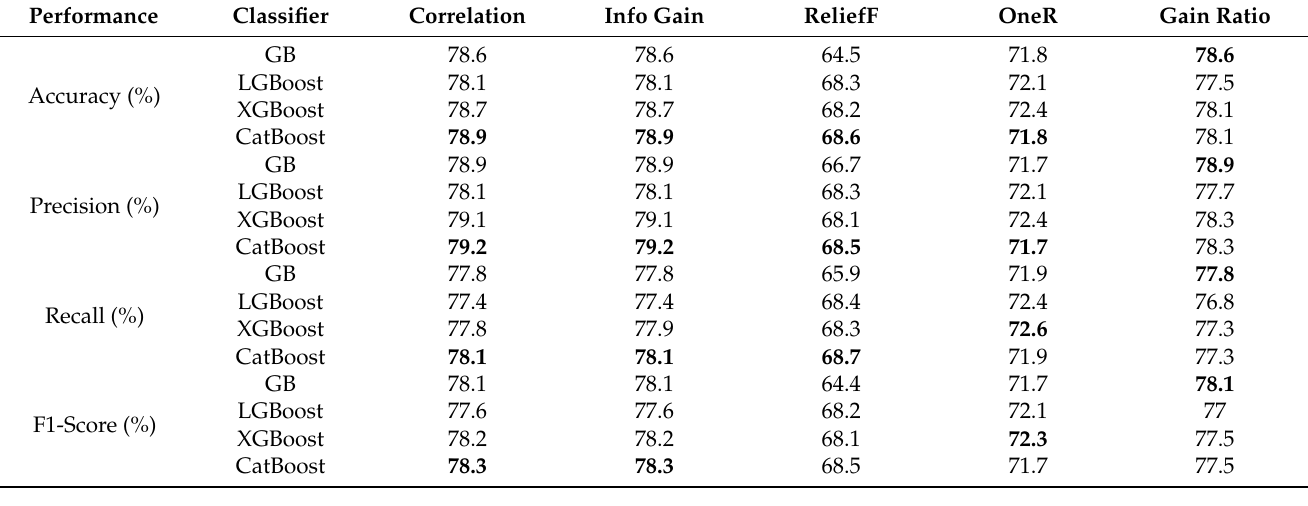
Table 7. Results of Near Miss with respect to each feature selection technique.